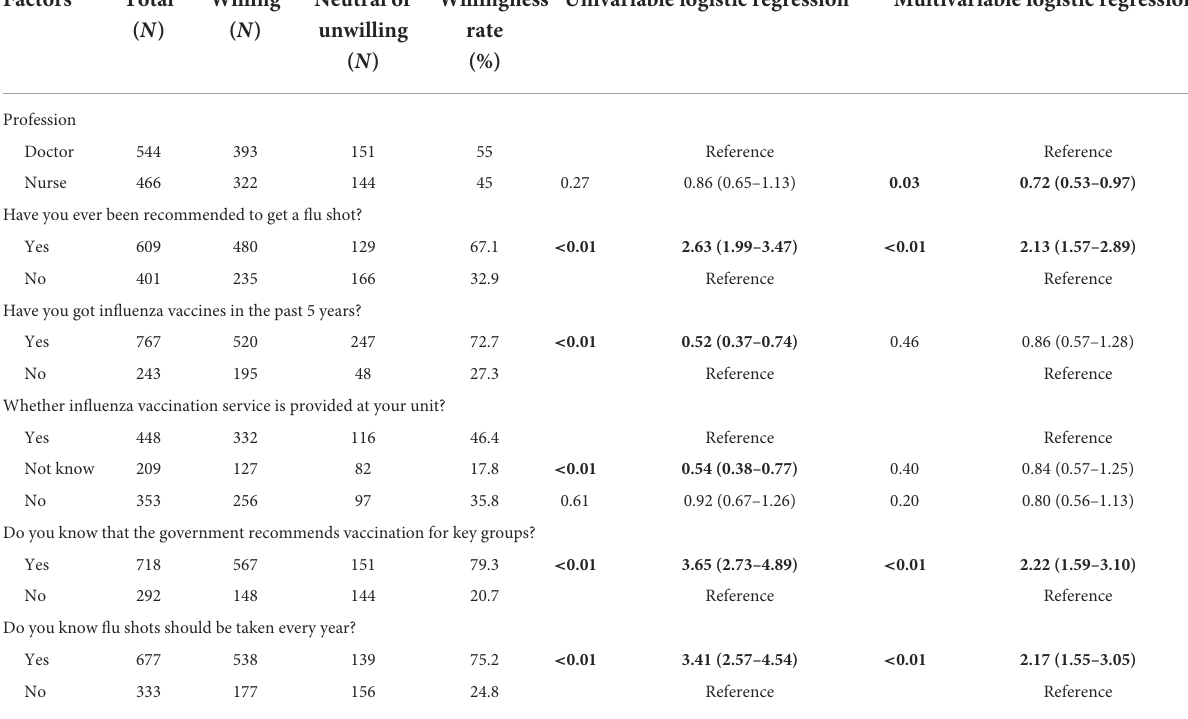
TABLE 3 Factors affecting healthcare workers’ willingness to recommend influenza vaccines-univariable and multivariable logistic regression